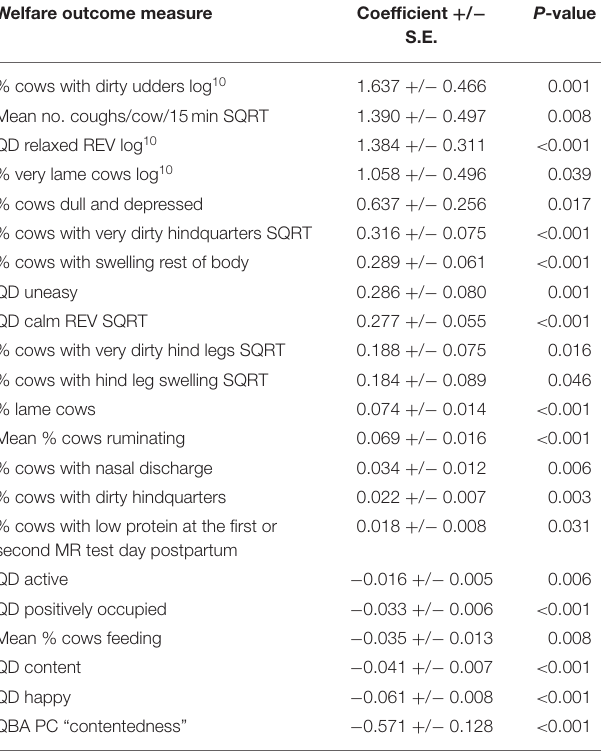
TABLE 3 | The 23 welfare outcome measures with factor loadings > 0.4 for principal component 1. Welfare outcome measure